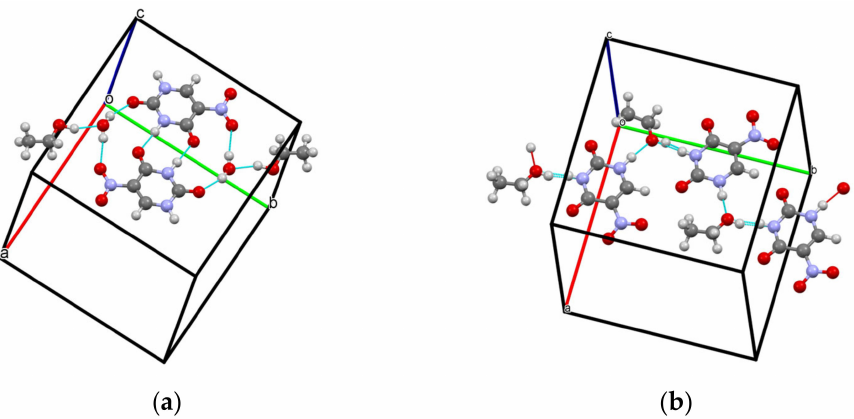
Figure 7. Hydrogen bond network in (VI) ( a ) Dimeric clusters; ( b ) ethanol/5NU chains.